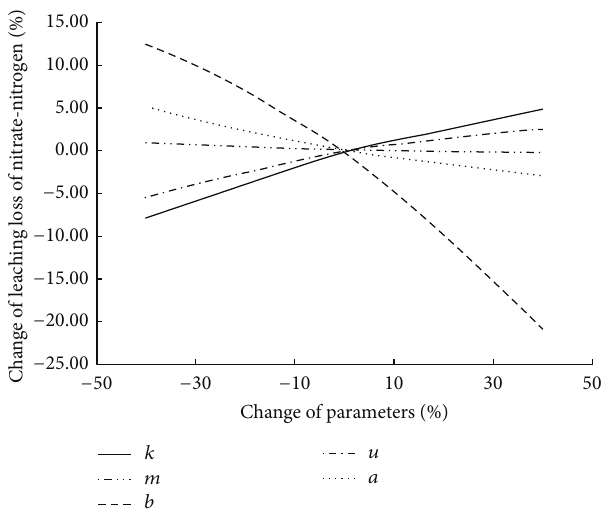
Figure 10: Sensitivity analysis for mainly parameters which affected the leaching loss of NO 3 -N in